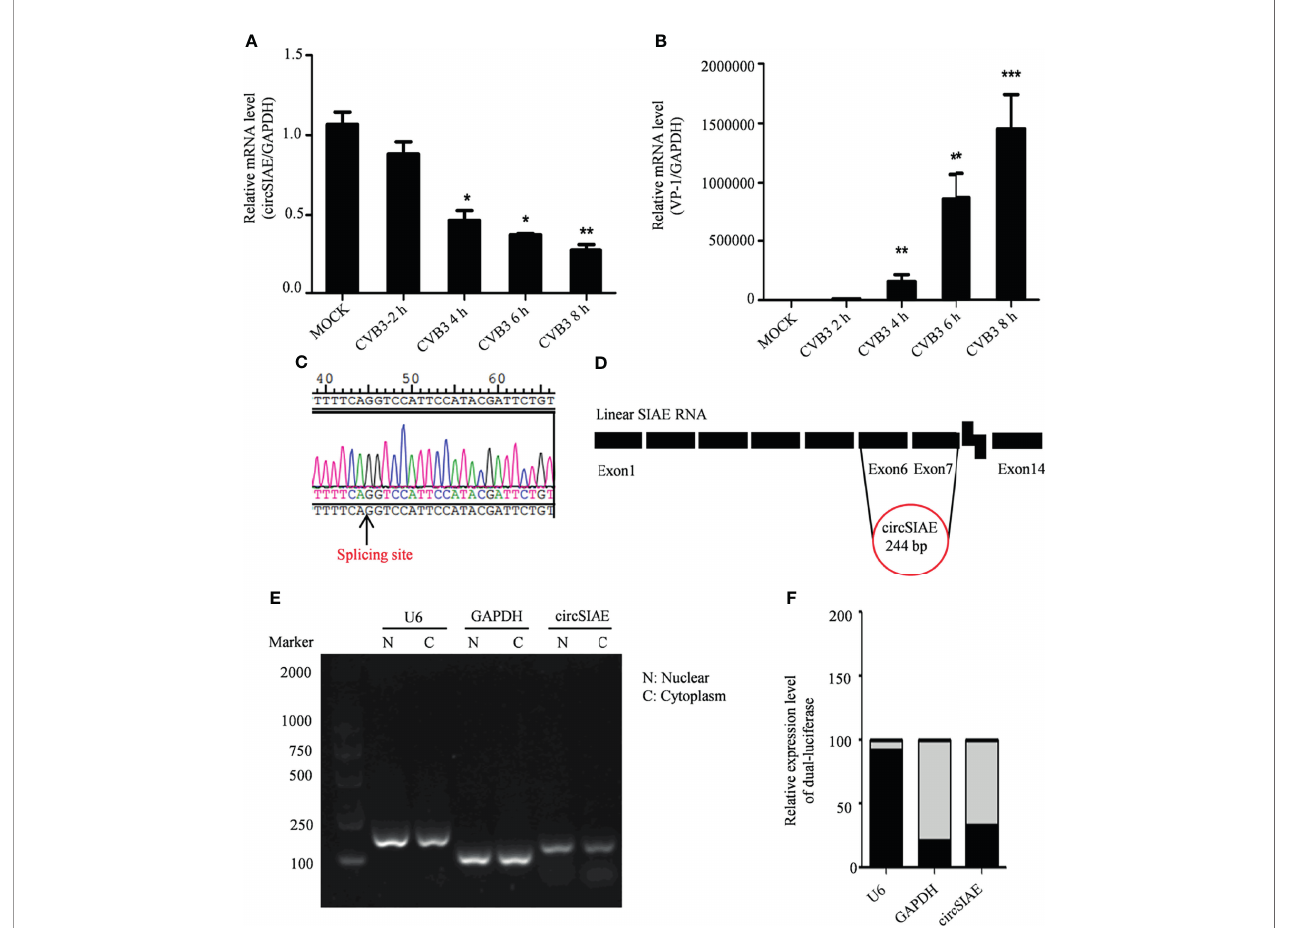
FIGURE 1 | Genomicstructure andlocationofcircSIAE. (A, B) TotalRNAwas extractedat 2, 4,6 and 8hpost-infection withCVB3, and theexpressionlevels ofcircSIAEand VP-1 atmRNAlevel wereanalyzedbyqRT-PCR. (C) . The splicesites ofcircSIAEweredetectedbysequencing. (D) . ThecircSIAEgenome is formedbyreversesplicing ofexons 6and 7of linear SIAE. (E, F) TotalRNA was isolatedfrom HeLa cellcytoplasm andnucleus, via a nucleoplasmic separationkit. GAPDH andU6wereused as cytoplasmic and nuclear markers. Theexpressionlevelof circSIAE inthecytoplasm wasveri fi edbyagarose electrophoresis (E) andqRT-PCR (F) . *p< 0.05, **p<0.01, ***p